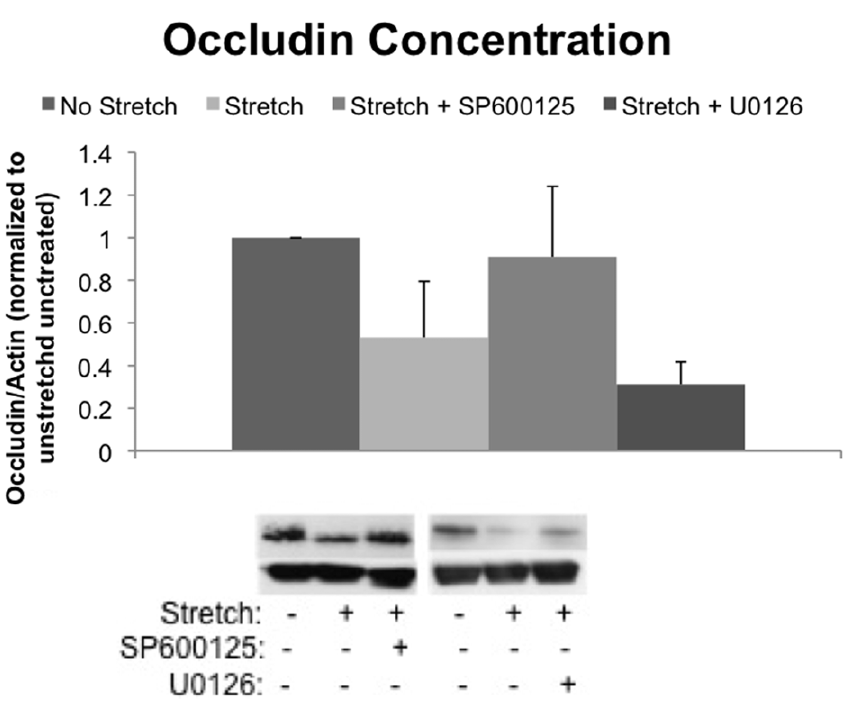
Figure 5. JNK inhibition prevents loss of occludin. Occludin concentration in cell monolayers significantly drops following 60 minutes of stretch (0.25 Hz, 37% D SA) compared to unstretched monolayers (*, p , 0.05). Treatment with the JNK inhibitor SP600125 blocked occludin decreases following 60 minutes of stretch, however ERK inhibition with U0126 did not. (N $ 3, m 6 SE).